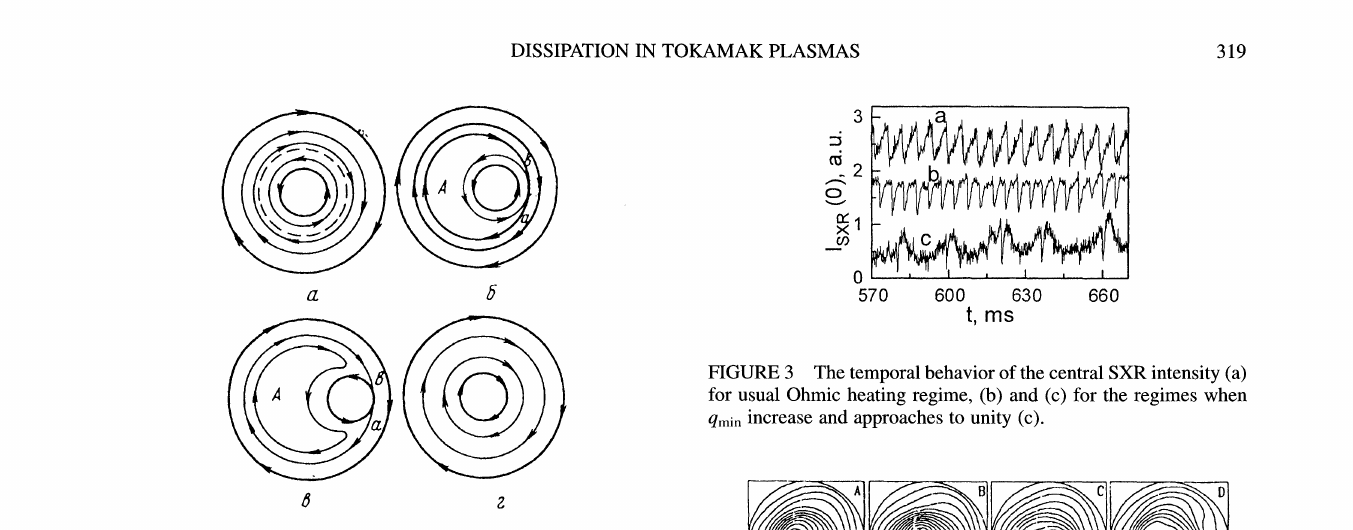
FIGURE 3 The temporal behavior ofthe central SXR intensity (a) for usual Ohmic heating regime, (b) and (c) for the regimes when qmin increase and approaches to unity (c).